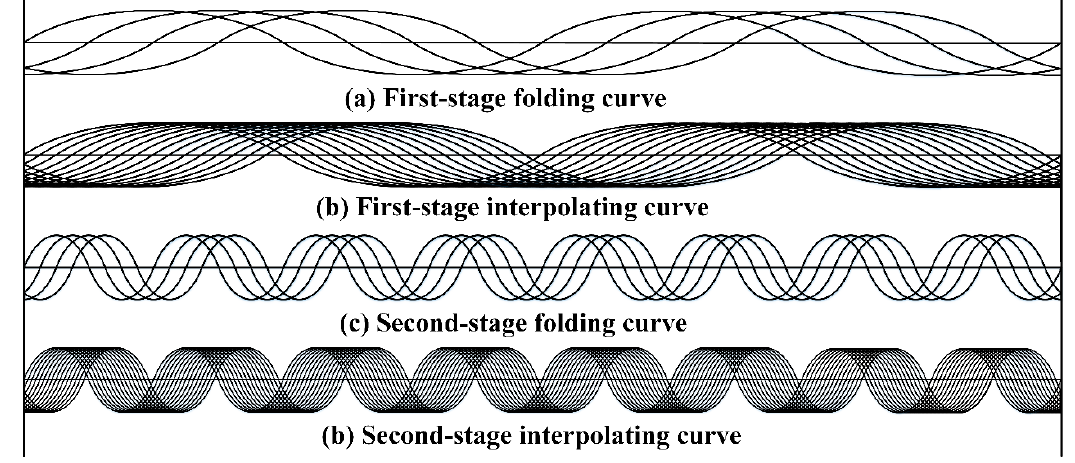
Figure 2. Radix-4 two-stage cascaded folding and interpolating curves.